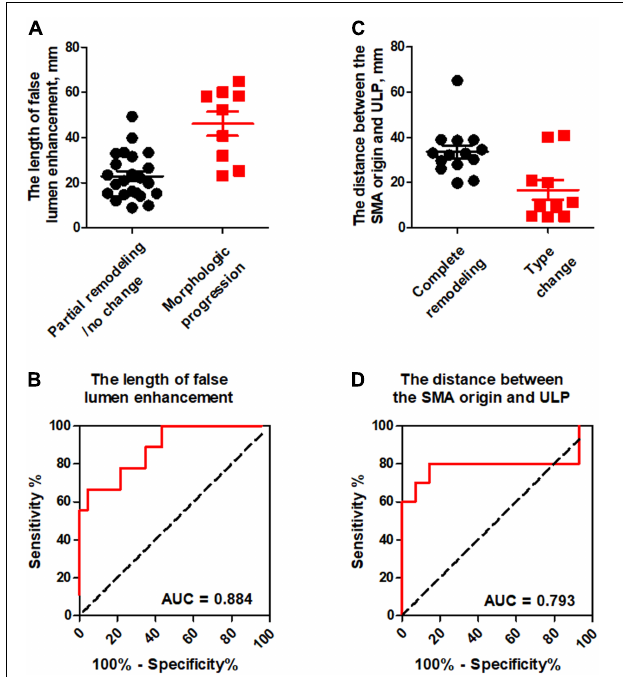
FIGURE 9 | ROC analysis for the prediction of dissection remodeling by the initial CT parameters. (A) The length of false lumen enhancement was statistically higher in morphologic progression than in partial remodeling/no change. (B) ROC curves indicated that the length of FL enhancement was an independent predictor for dissection progression in type II dissection with a patent “cul-de-sac” false lumen but no re-entry with the AUC of 0.884. (C) The distance between the SMA orifice and ULP was significantly lower in type change than in complete remodeling. (D) ROC curves revealed that the distance between the SMA orifice and ULP had the AUC of 0.793 and negatively predicted the type change in type III lesion with thrombosed false lumen with